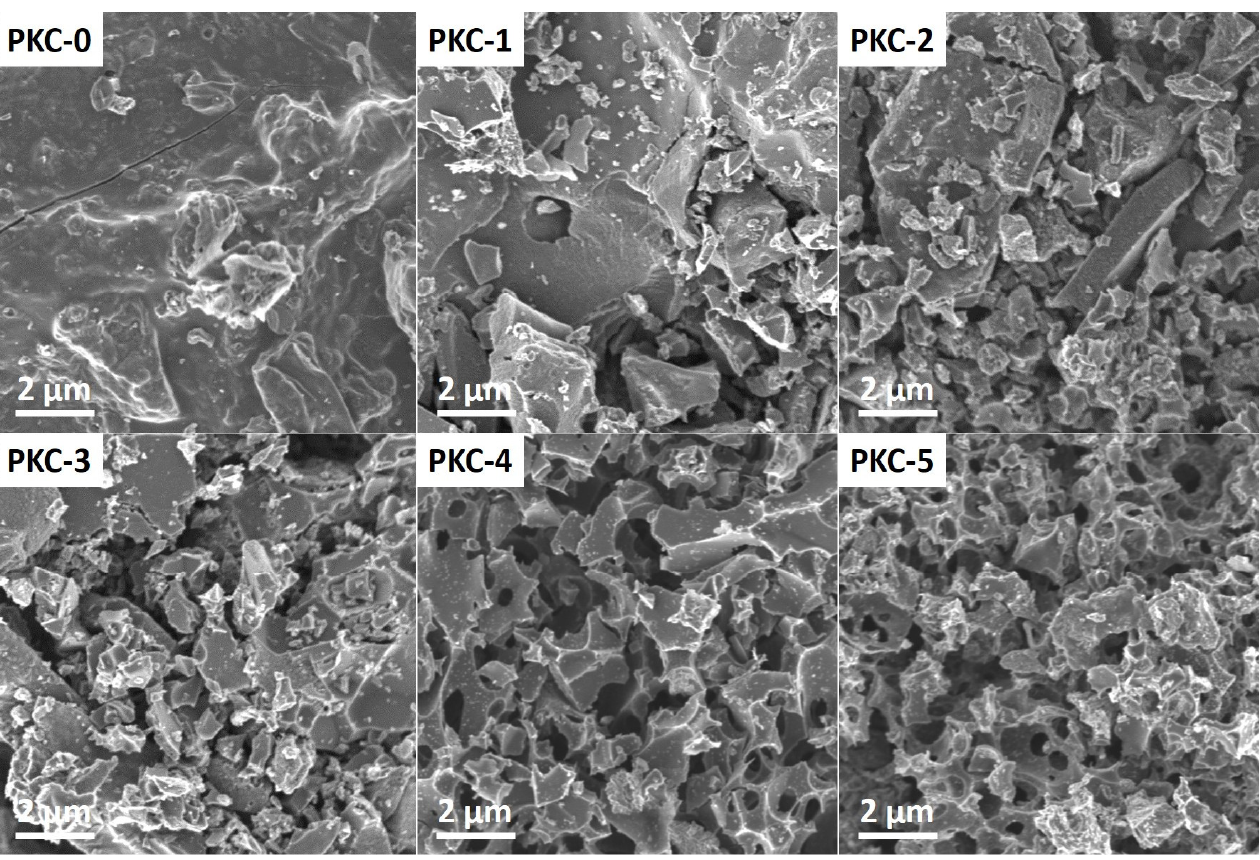
Figure 1. SEM images of biochars prepared from poplar leaves with KHCO 3 as activator (×5000). Raman spectra were performed to analyze the graphitization degree of these biochars. As shown in Figure 2, all patterns display two distinct peaks, which can be assigned to D-band (around 1340 cm − 1 ) and G-band (around 1590 cm − 1 ), corresponding to amorphous carbon and graphitic carbon in biochars, respectively [41]. The intensity ratio ( I G / I D ) of G-band to D-band was used to reflect the graphitization degree of biochars [42]. As shown in Table S2 (Supplementary Materials), with the increase of the KHCO 3 addition, the I G / I D ratios decrease from 0.993 to 0.850, indicating that KHCO 3 destroys the biochar matrix and reduces its graphitization degree.